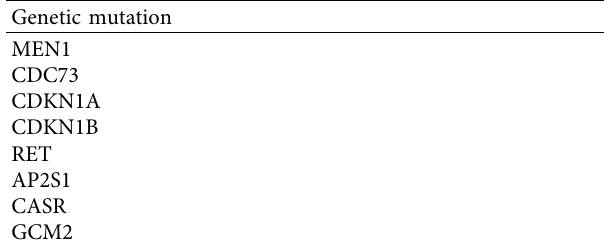
Table 2: Genetic mutations